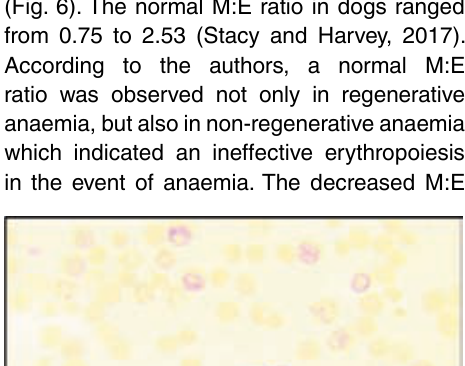
(Fig. 6). The normal M:E ratio in dogs ranged from 0.75 to 2.53 (Stacy and Harvey, 2017).